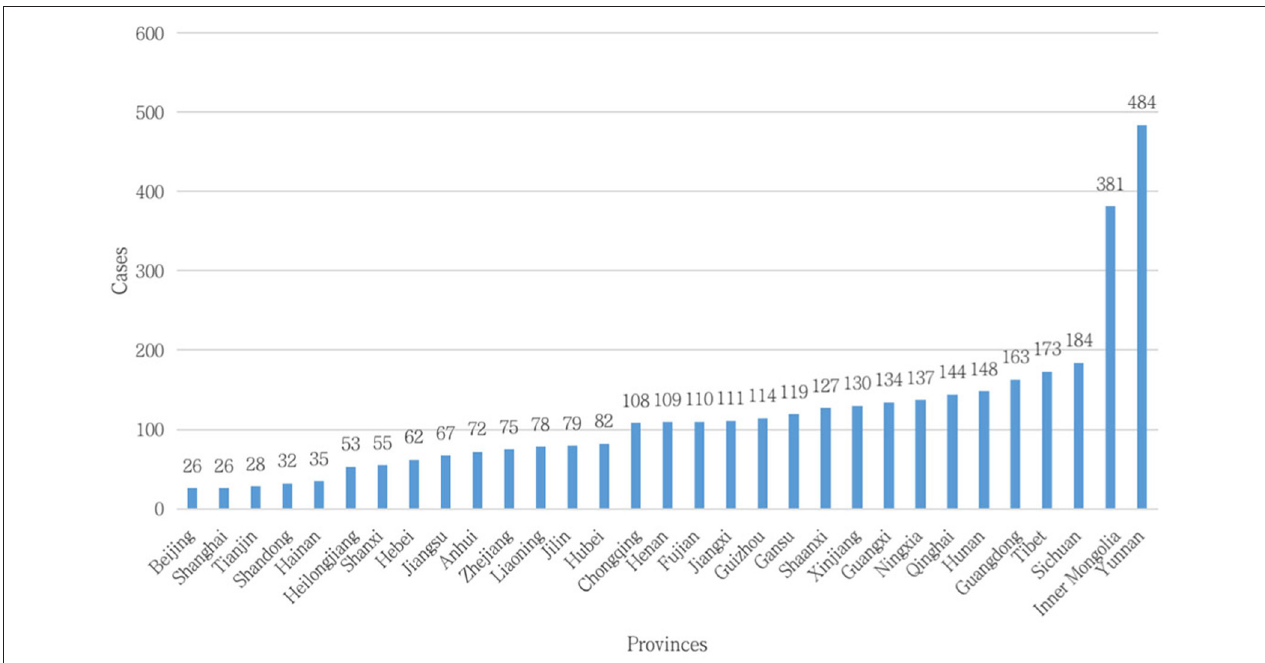
FIGURE 3 | Provincial distribution of wildlife crimes.